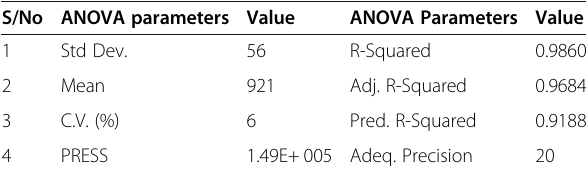
Table 8 Goodness of fit statistics for validating